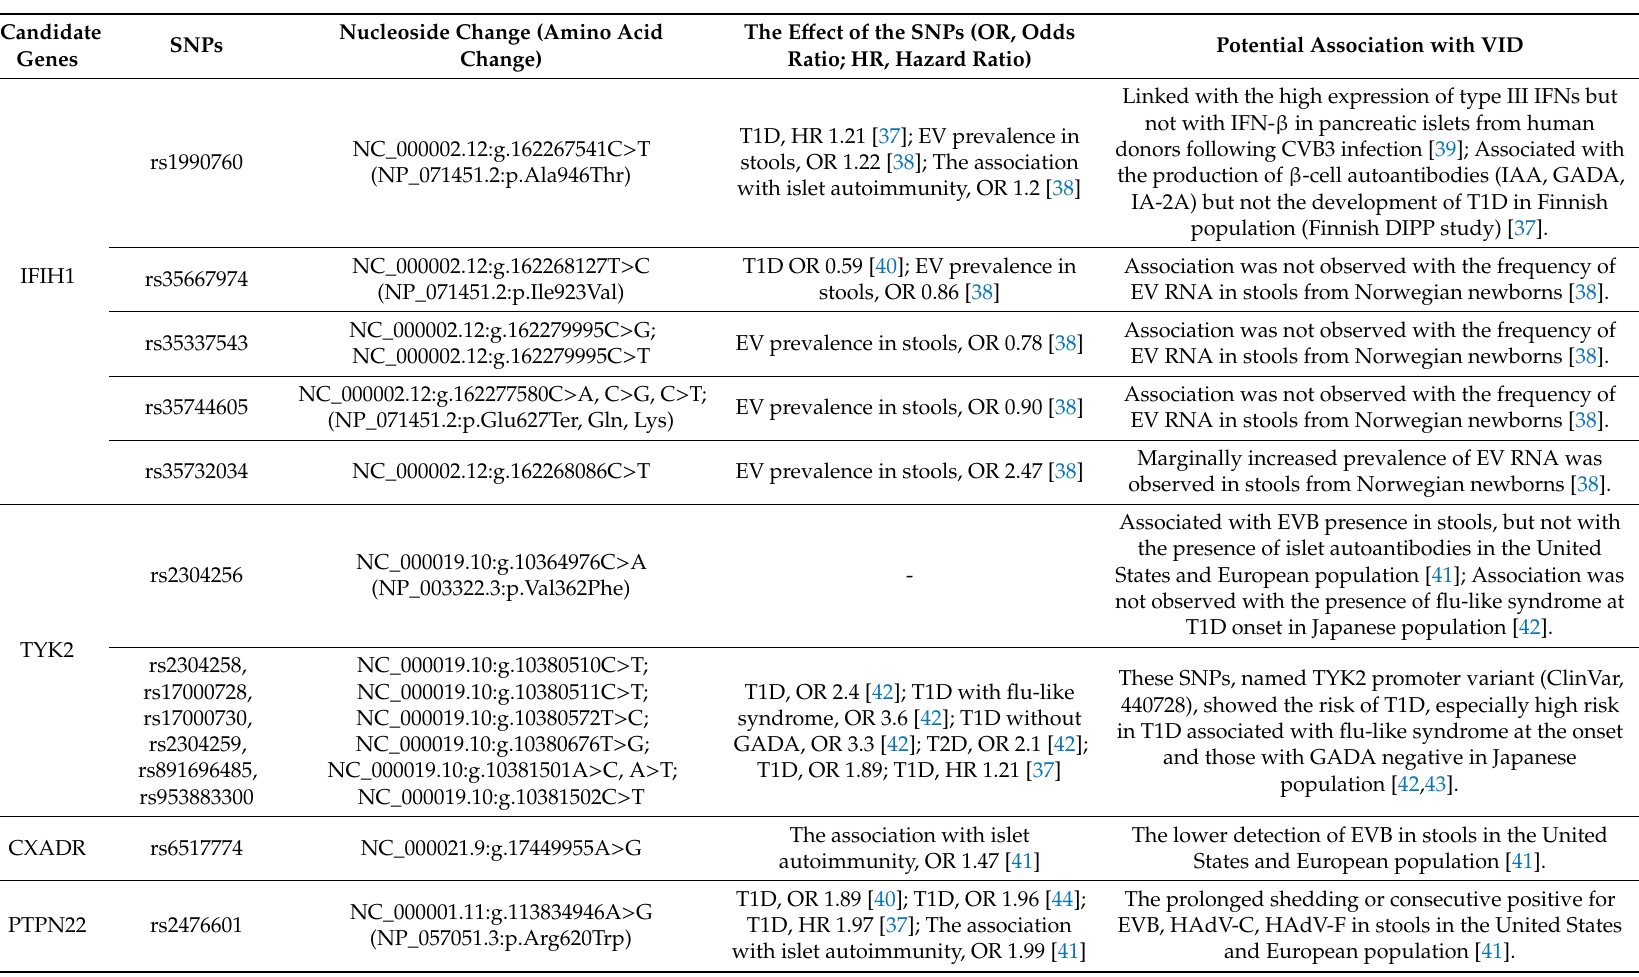
Table 2. List of potential Single Nucleotide Polymorphisms (SNPs) associated with human Virus-Induced Diabetes